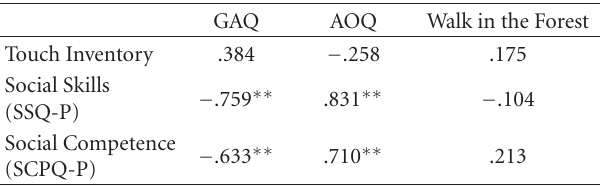
Table 1: Correlations between measures of a ff ection and other